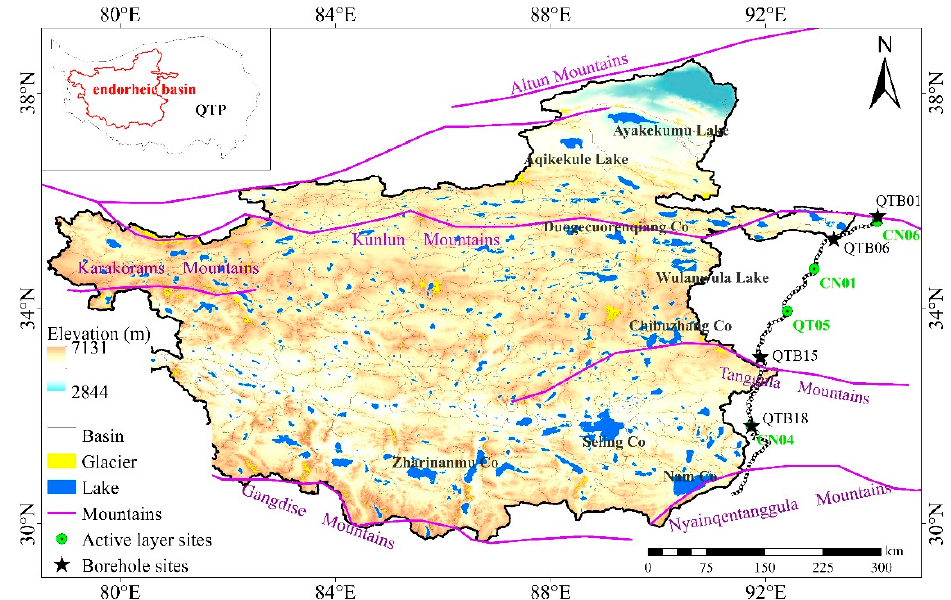
of the entire QTP), with a width of 950 km from north to south and a length of 1359 km from east to west. It consists of 400 endorheic drainage basins with an average elevation of about 4894 m a.s.l. (Figure 1). The climate across the endorheic basin ranges from temperate arid to subarctic semi-humid. Dominated by the Indian monsoon in summer and cold-dry westerlies in winter, the climate indicates ◦ a strong seasonal variation [7]. The mean annual air temperature is near or below 0 C. The mean annual precipitation is 50~300 mm; at least 60%~90% of the total annual precipitation falls between June and September, while less than 10% falls in winter between November and February. It is windy in winter and spring; approximately 200 days with a wind speed of more than 17 m / s has occurred. The endorheic basin is characterized by lack of surface runo ff , a sparse river network and more seasonal rivers. The endorheic basin is a typical alpine frost sparse steppe, accounting for 64.5% of the total area. Most of the lakes on the QTP are located in the endorheic basin; it contains approximately 780 lakes larger than 1 km 2 , which accounted for more than 73% of the total lake numbers and areas [7]. Several large lakes more than 1000 km 2 , such as Seling Co (2405 km 2 ), Ayakekumu Lake (1041 km 2 ), Chibuzhang Co (1073 km 2 ) and Nam Co (2022 km 2 ), were located in this basin.